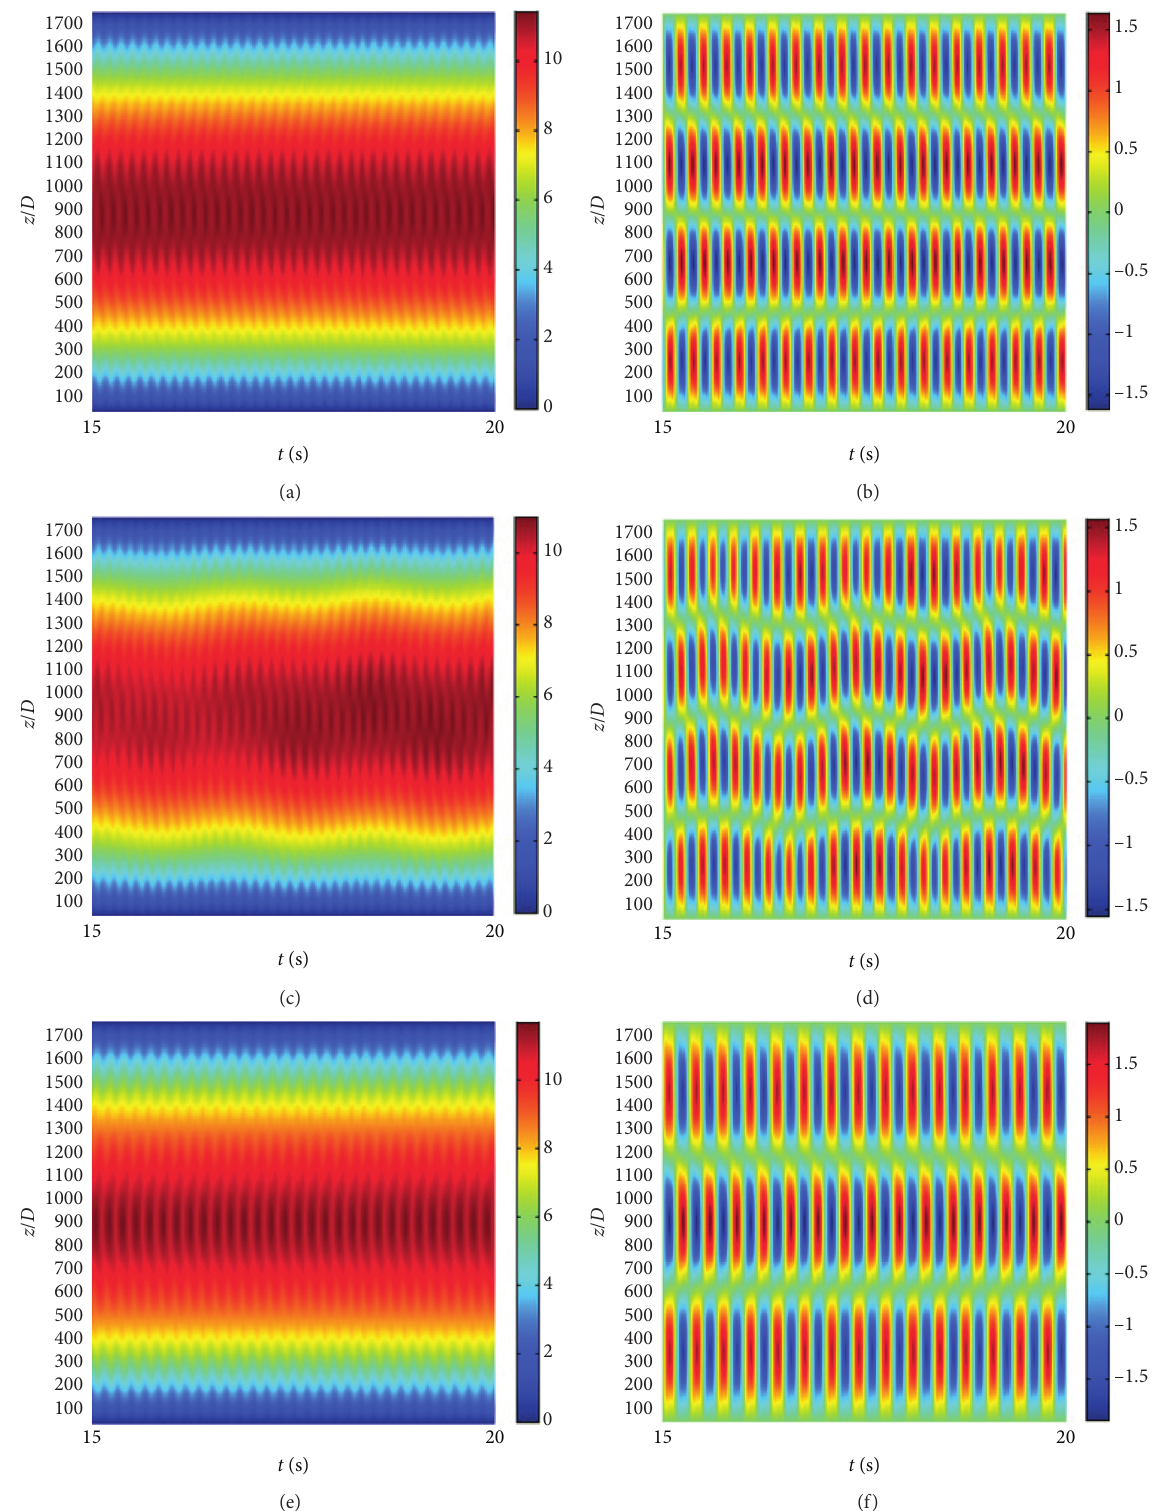
Figure 15: Space-time response of displacement under different gas-phase volume fractions. (a) The in-line and (b) cross-flow with ε (c) The in-line and (d) cross-flow with ε g � 0.7. (e) The in-line and (f) cross-flow with ε g �